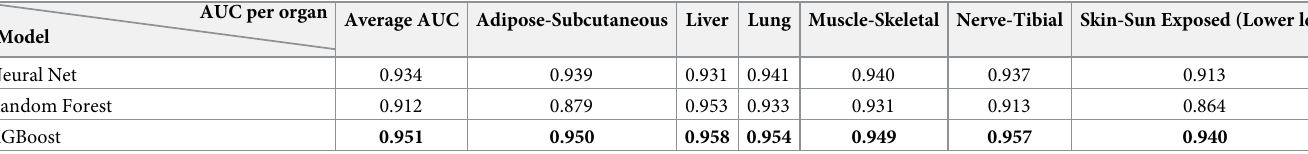
Table 3. Binary classification models’ AUCs for the different organs. Model